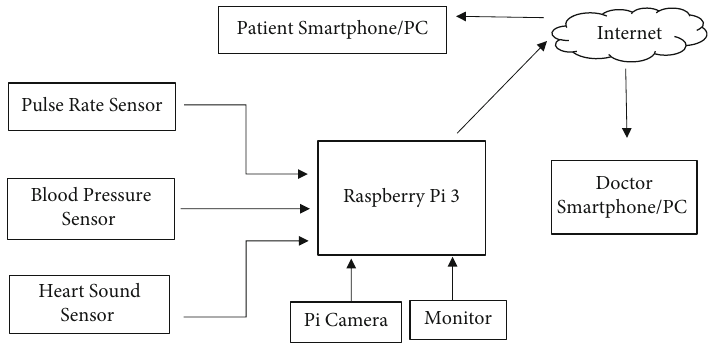
Figure 1: Block diagram.